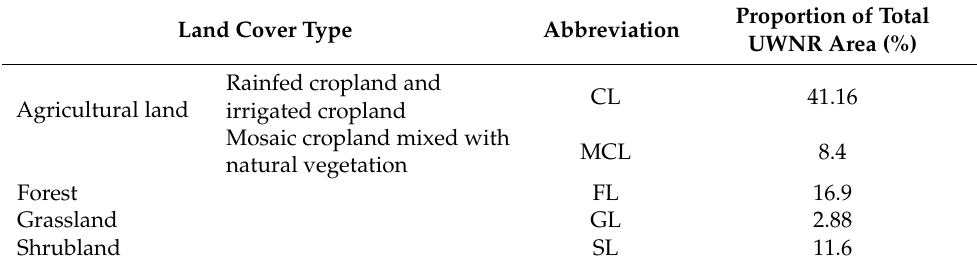
Table 1. Percentage of area occupied by various vegetation types in the